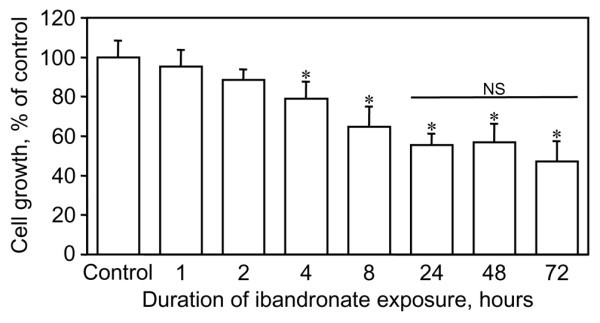
Effects of various durations of exposure of MCF-7 cells to ibandronate. Cells were cultured in steroid-free medium and exposed to 10-4 M ibandronate or vehicle (control) for 1 to 72 h (pulse exposures). Cell growth measurements were performed after 72 h as described in Fig. 1. Asterisks indicate ANOVA p < 0.01 versus control, Tukey post hoc test. NS, not significant.